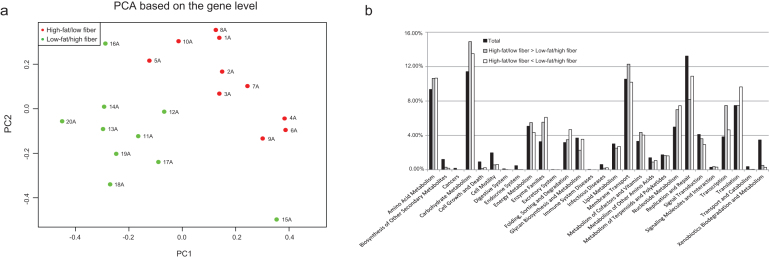
Diet-related differences in the cynomolgus macaque gut microbiota. (a) PCA of cynomolgus macaque samples based on gene profiles. (b) KEGG functional classification of the 82,120 gene makers. The black bars represent the total percentage in the 1.9-M gene catalog. The gray bars represent gene markers enriched in the high-fat/low-fiber diet group. The white bars represent gene markers enriched in the low-fat/high-fiber control group.